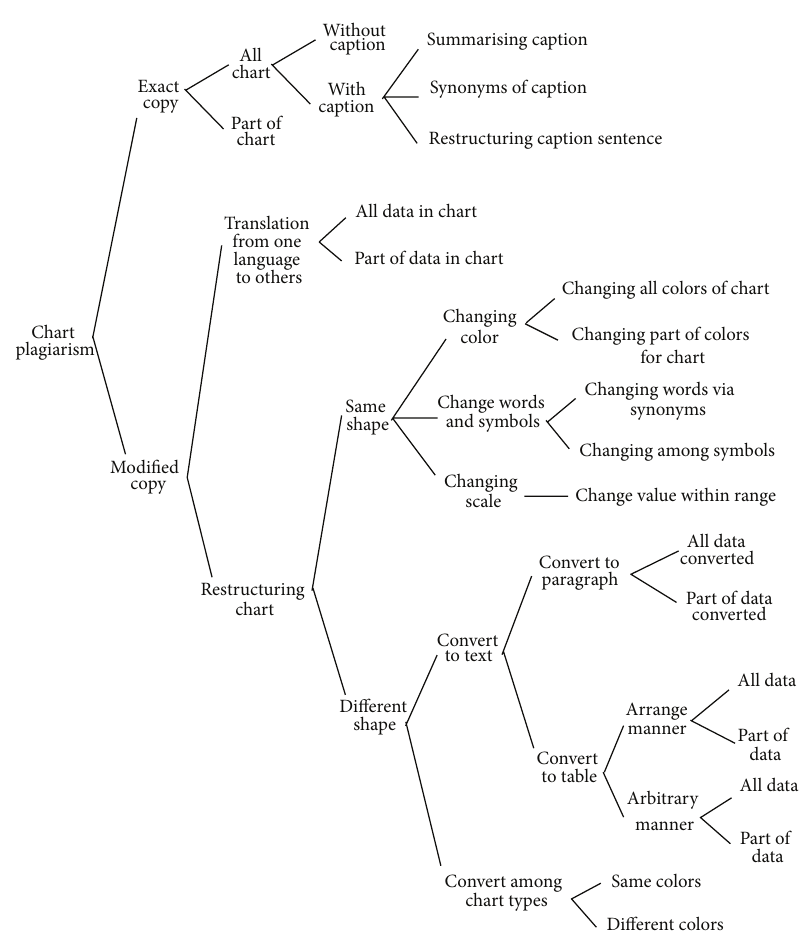
Figure 1: Taxonomy of chart